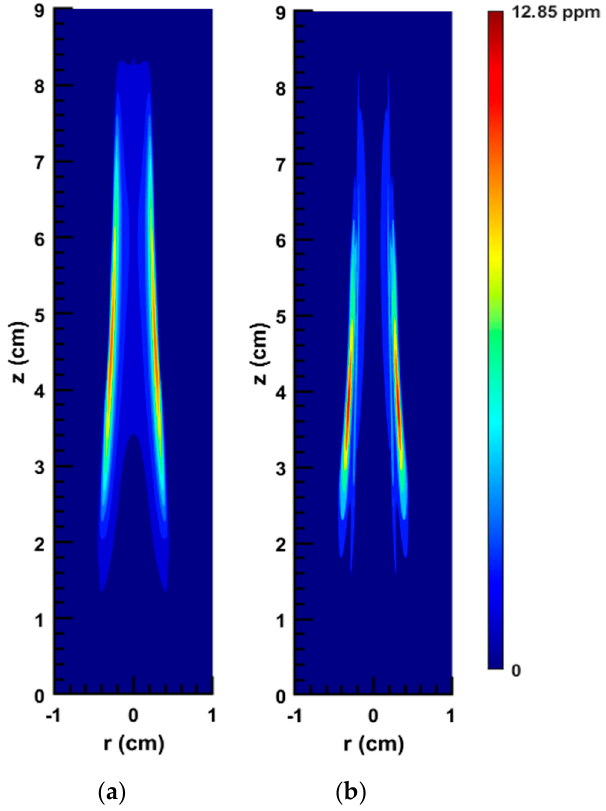
Figure 12. 2D soot concentration field of the SA flame: ( a ) original numerical solution; ( b ) ANN prediction.